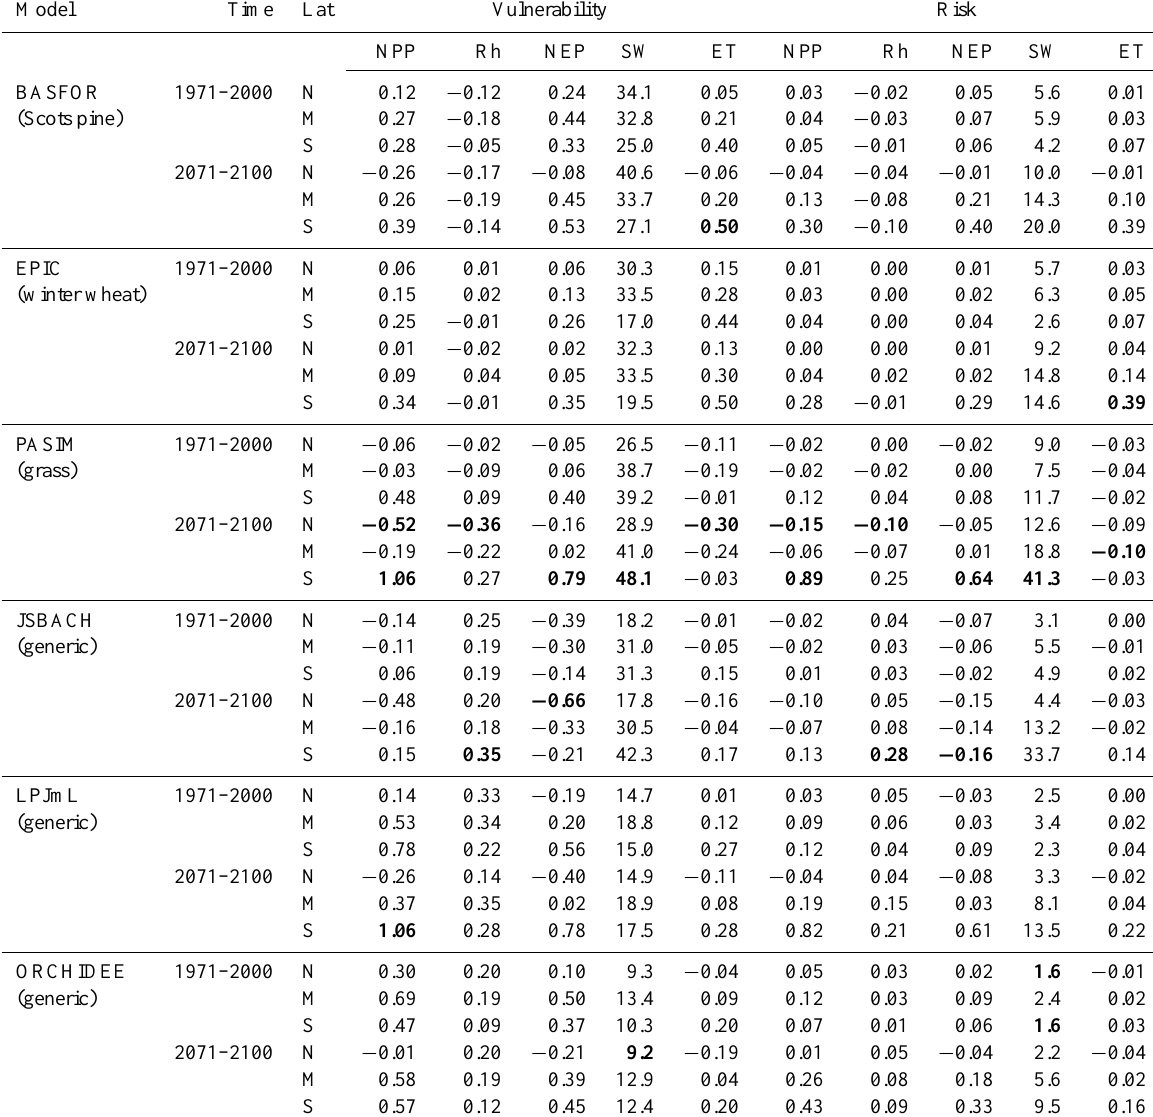
Table 2. Drought vulnerability and risk of the carbon and water balance across Europe. Averages for two time periods and three latitudi- nal bands, calculated by six models. N is above 55 ◦ N, M is between 45 and 55 ◦ N, S is below 45 ◦ N. NPP is net primary